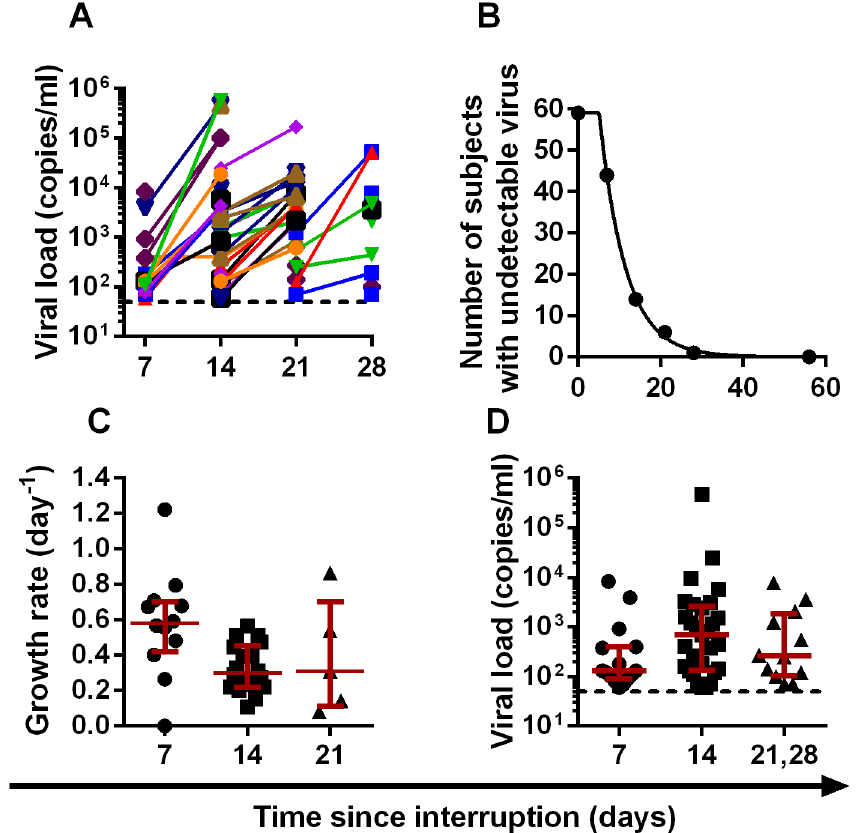
Fig 3. Dynamics of recrudescence in 59 patients enrolled in the Pulse study (reference [15]). (A) Trajectory of viral load in individual patients. Dashed line indicates threshold of detection (50 copies ml -1 ) (B) survival curve of time to detection (frequency of initiation of viral replication is once every 6.3 days). (C) Growth rate estimated from first two weeks of detectable virus. (D) Average viral load at detection for patients detected at different weeks. Dashed line indicates threshold of detection (50 copies ml -1